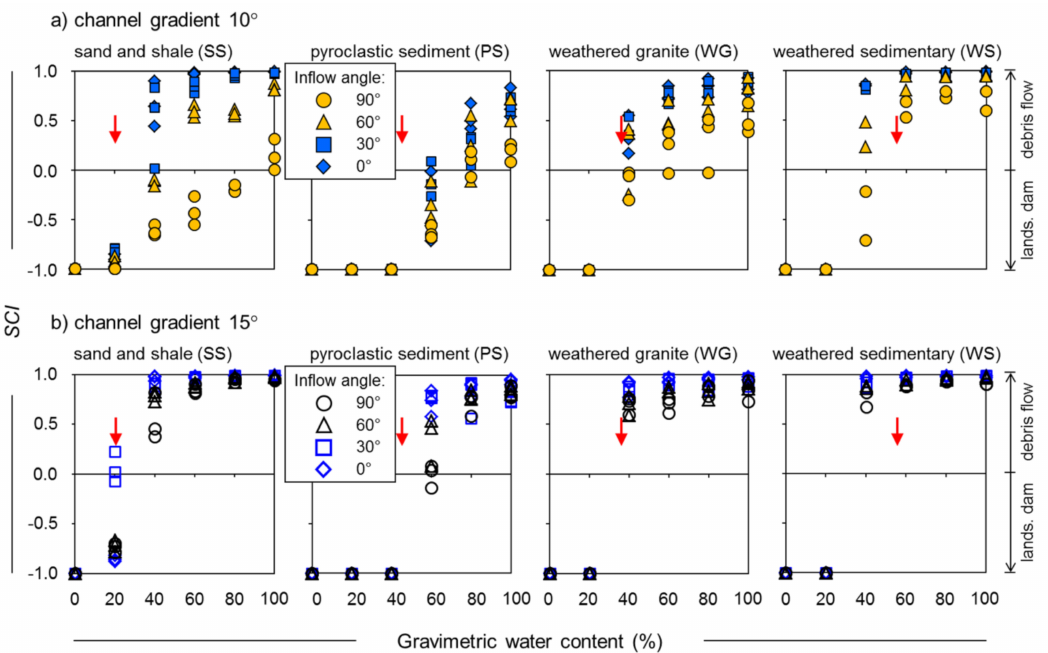
Figure 7. Sediment Connectivity Index ( SCI ) for the classification of landslide dams and debris flows. The arrows represent the different saturated water contents of sediments. ( a ) Sediment deposition for the 10 ◦ channel gradient; ( b ) sediment deposition for the 15 ◦ channel